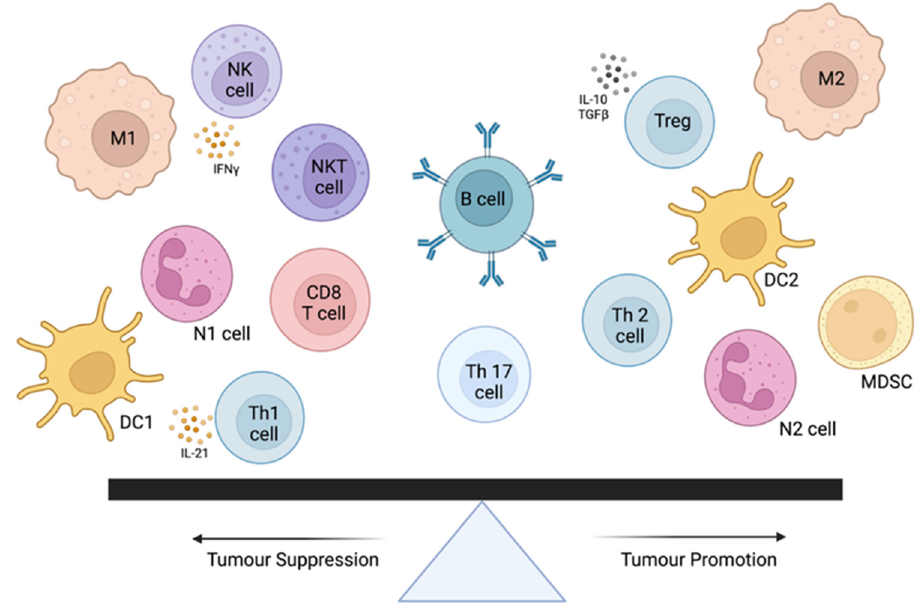
Figure 1. The immune cellular microenvironment of cancer. Pro-tumorigenic immune cell types include T-regulatory cells (Tregs), M2 macrophages, dendritic cells (type 2), myeloid-derived suppressor cells (MDSCs), T-helper 2 (Th2) cells, and neutrophils (N2). Anti-tumor immune cell types include CD8+ T-cells, T-helper 1 (Th1) cells, neutrophils (N1), dendritic cells (type 1), natural killer (NK), and natural killer T-cells (NKT). These cells, their relative abundance, and microenvironmental signals play a critical role in anti- or protumor activity of cancer cells. Salgado et al., Harmonization of the evaluation of tumor infiltrating lymphocytes (TILs) in breast cancer: recommendations by